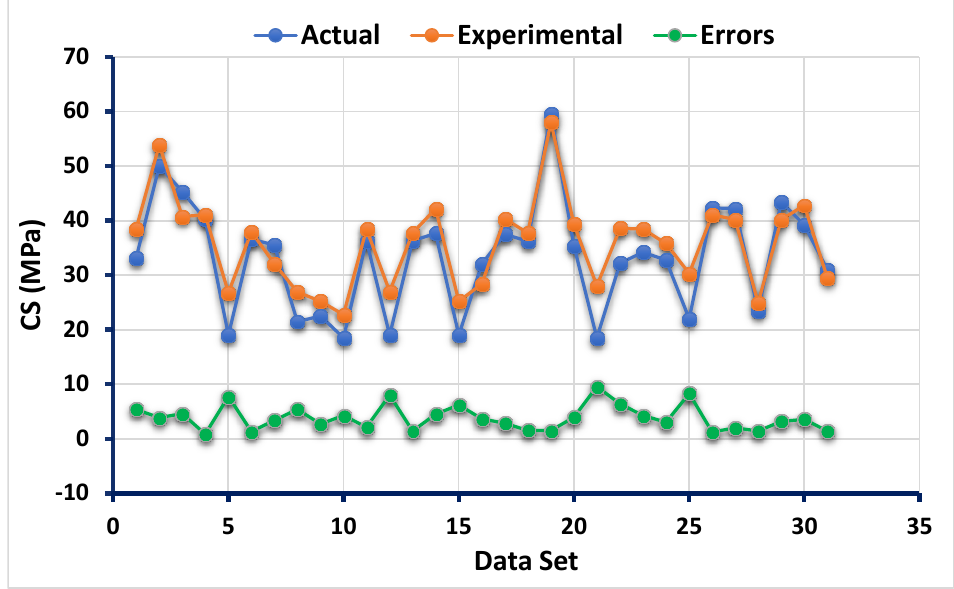
Figure 3. Error distribution of the targeted and predicted results from the ANN model.